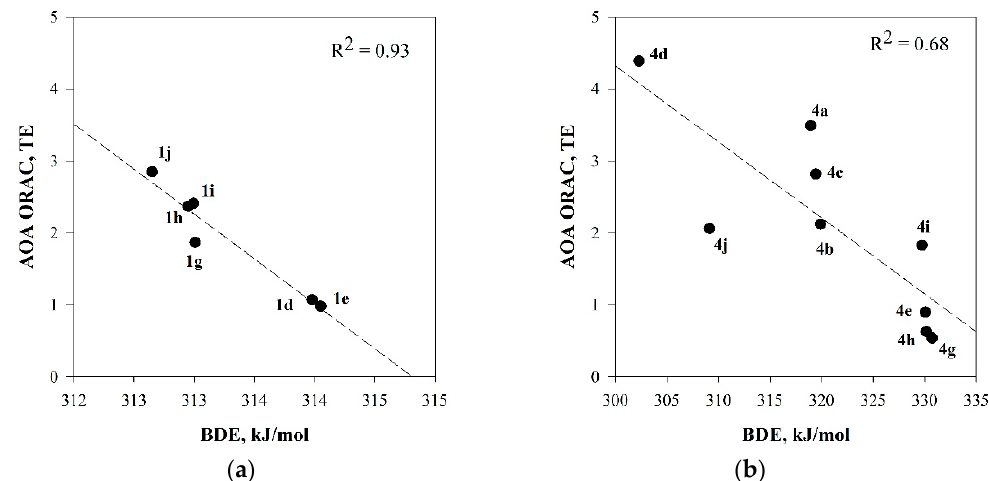
Figure 3. Antioxidant activity (AOA, ORAC) vs. BDE functions for 4-hydroxyimino-1-phenyl- pyrazolones 1e – j ( a ) and antioxidant activity (AOA, ORAC) vs. BDE functions for polyfluoroalkyl 4-aminopyrazolols 4a – c , 4e – i ( b ).